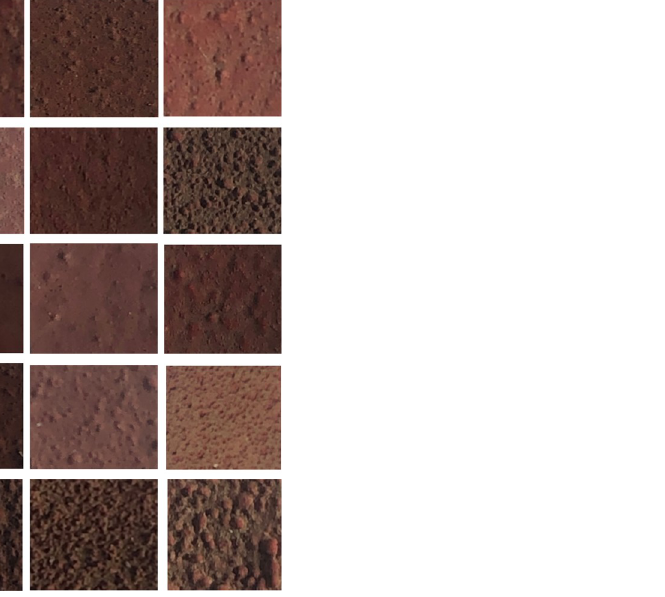
Fig 1. 20 typical pieces of RTV samples.